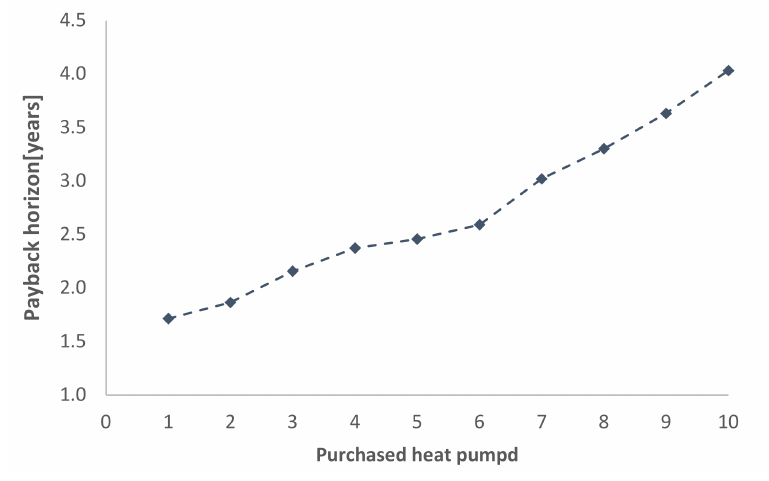
Figure 4. Payback time according to the number of heat pumps